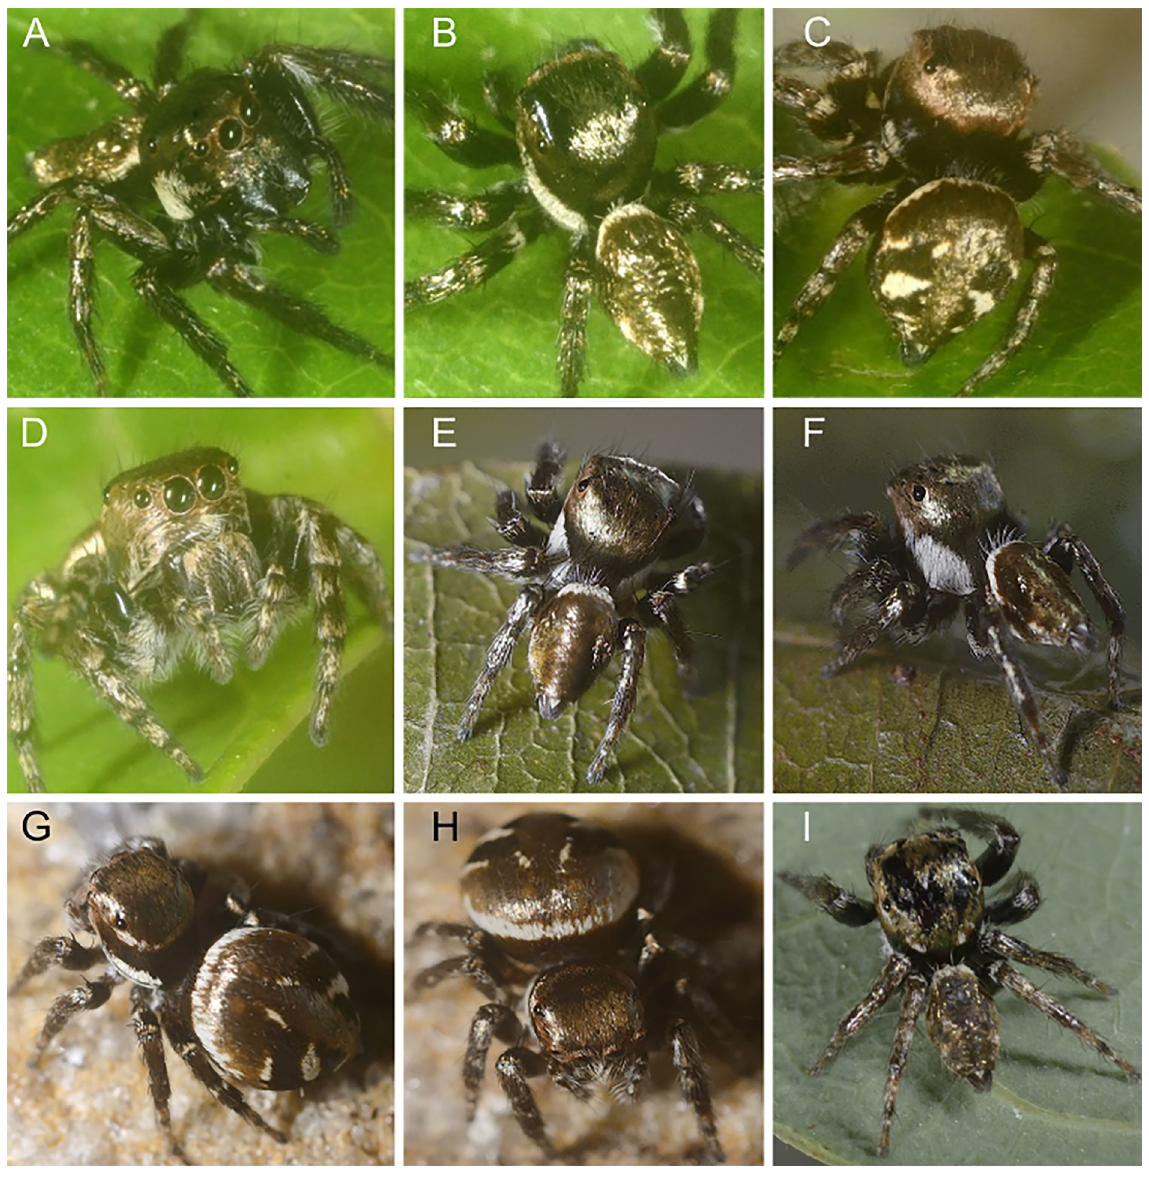
Fig 5 . Photographs of live Carrhotus atratus sp. nov. A–B , E–F , I . Males. C–D , G–H . Females. A–H from Mandaitivu, I from